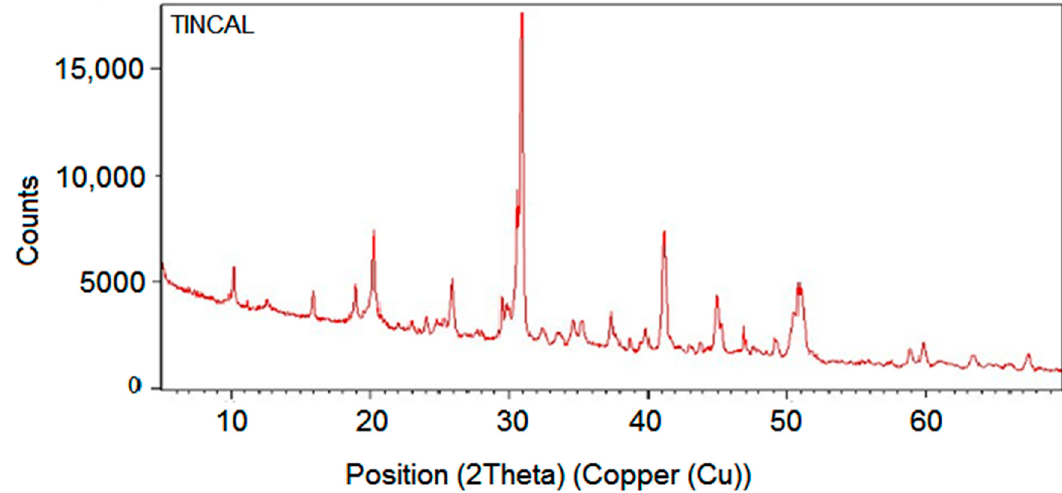
Figure 7. The XRD pattern analysis of solid phase tincal that was obtained from the separation process (the 0.075 mm (200-mesh) fraction) (the highest peak indicates tincal).